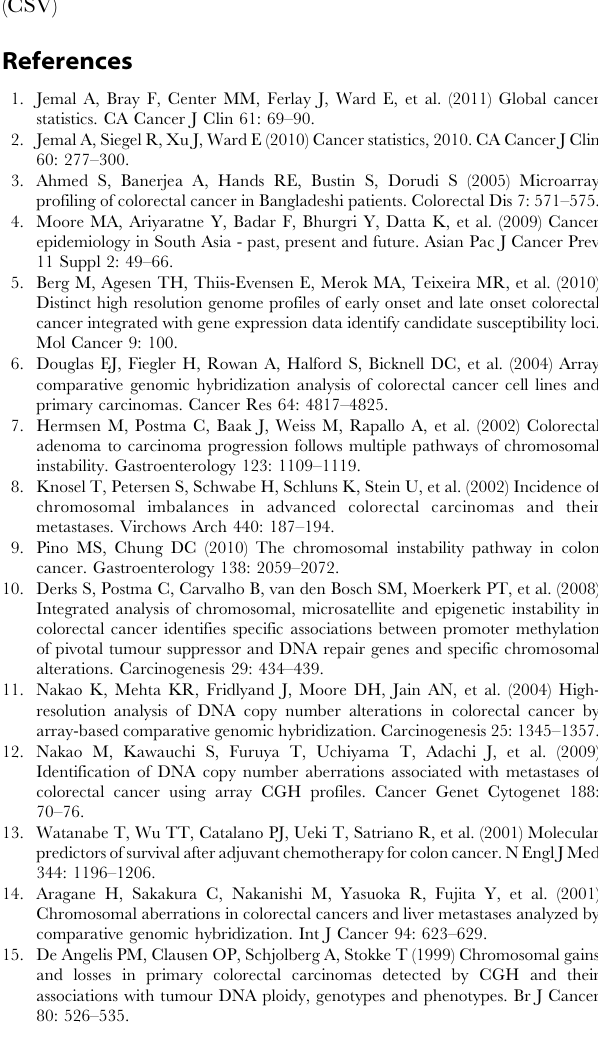
Table S6 Association of CN changes with lymph node metastasis. Table S7 Therapeutic Target Database matches for: (A) antibody, antagonist, inhibitor targeting genes in the amplification regions; (B) agonist, activator and inducer targeting genes in the deletion regions. (CSV) Table S8 List of genes found to be significantly amplified in tumor tissue in at least 10% of samples. (CSV) Table S9 List of genes found to be significantly deleted in tumor tissue in at least 10% of samples.